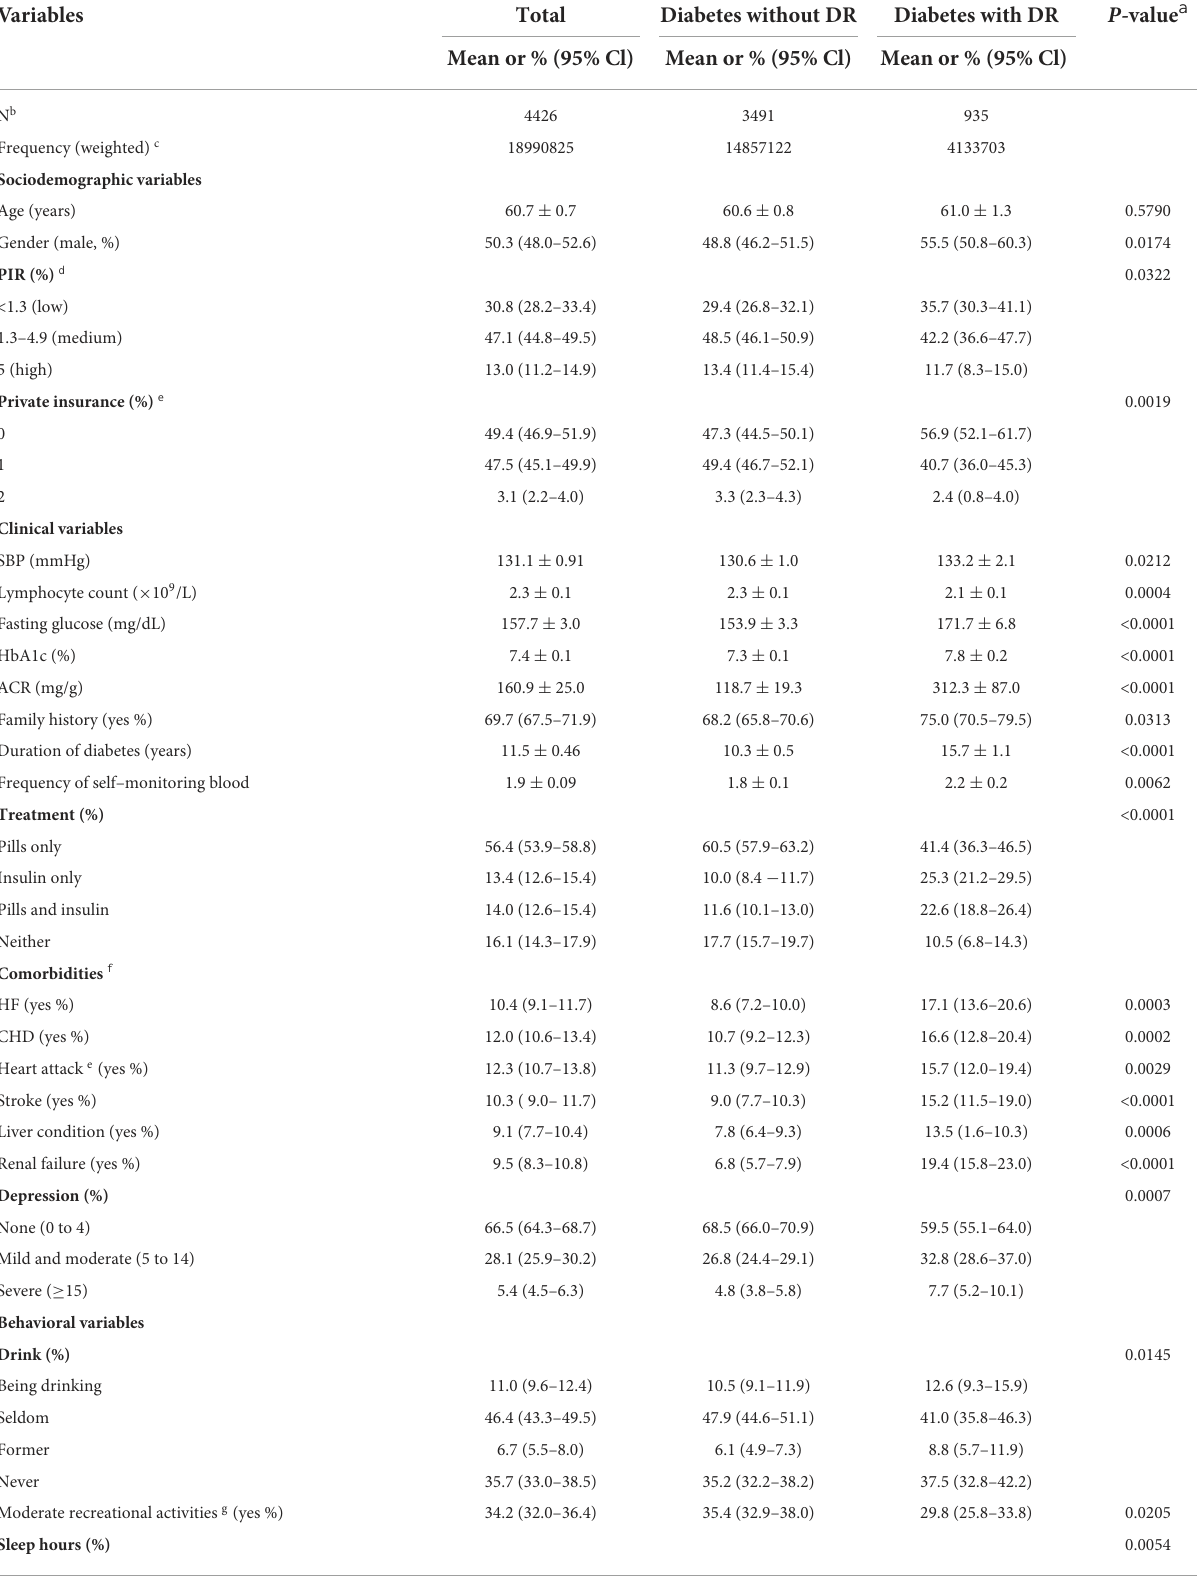
TABLE 1 Baseline characteristics of diabetes in